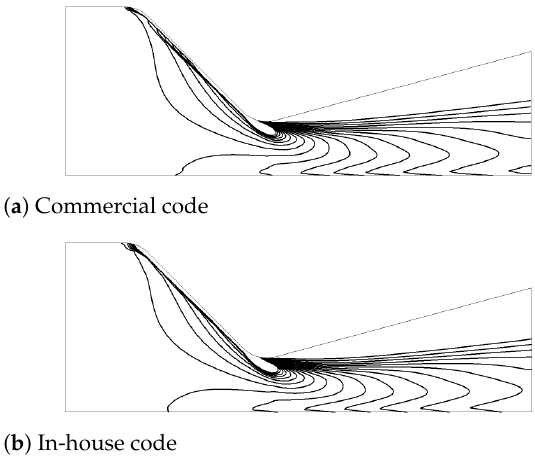
(cid:2) (cid:3) 7.2 10 − 5 0.001 ∈ · · · ·